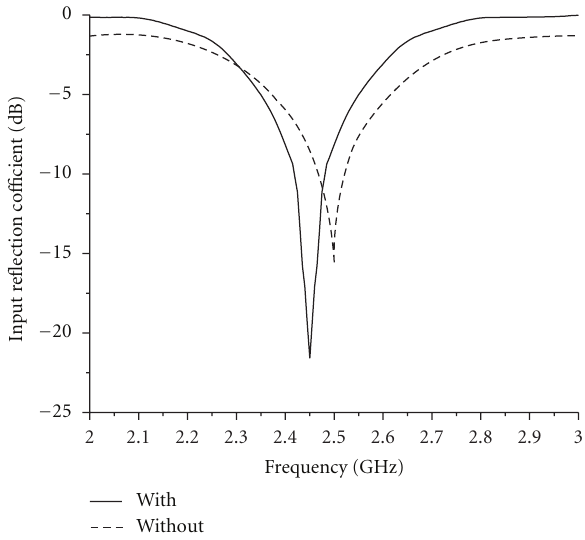
Figure 4: Input reflection coe ffi cient comparison of the antenna with or without a trident-shaped feeding strip and 4 pairs of triangular slot